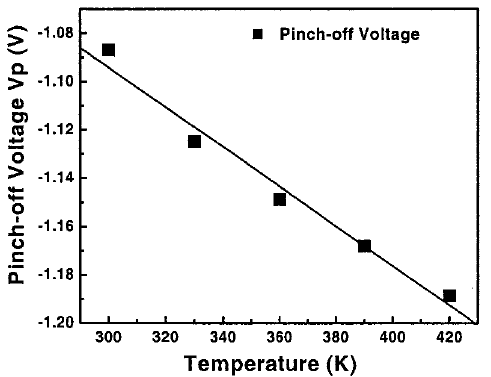
FIGURE 10 The pinch-off voltage versus temperature of AlGaAs = InGaAs = GaAs